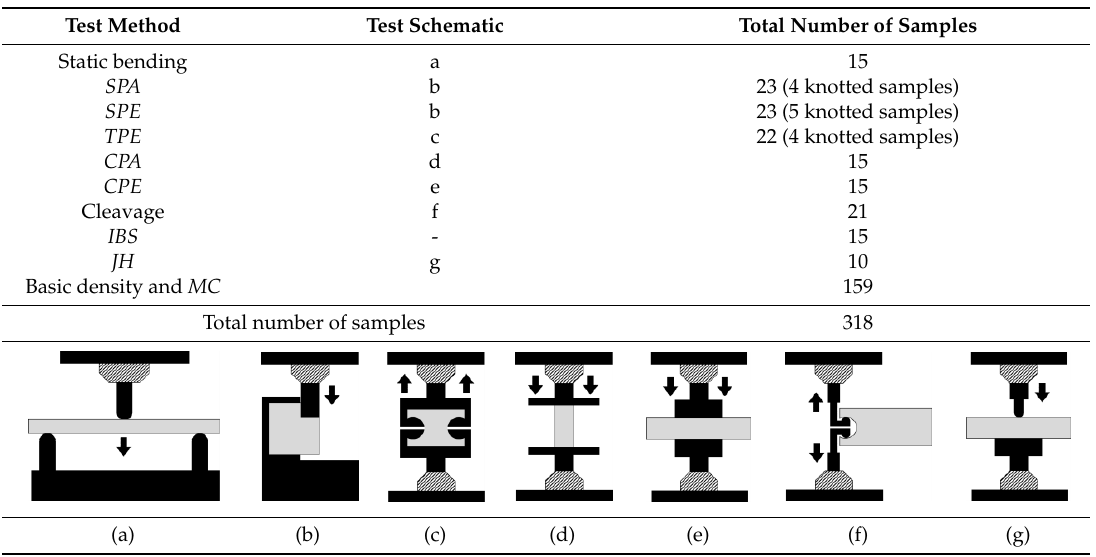
Table 1. Experimental design of the study. Abbreviations: shear strength parallel ( SPA ) and perpendicular ( SPE ); tensile strength perpendicular to the grain ( TPE ); compressive strength parallel ( CPA ) and perpendicular ( CPE ) to the grain, cleavage; impact bending strength ( IBS ); Janka hardness ( JH ); moisture content ( MC ).